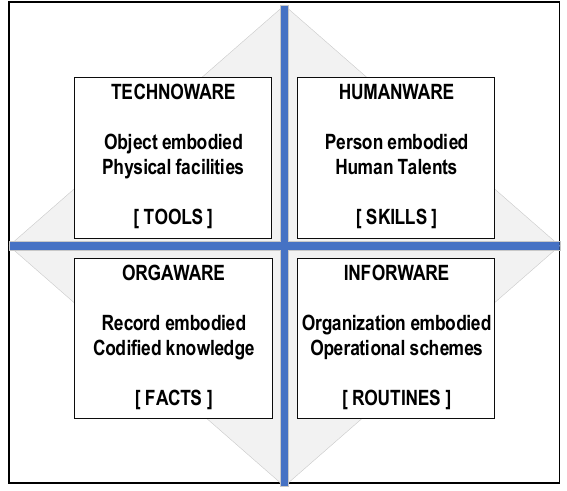
Figure 2. Technology system components. Source: Smith & Sharif [91].